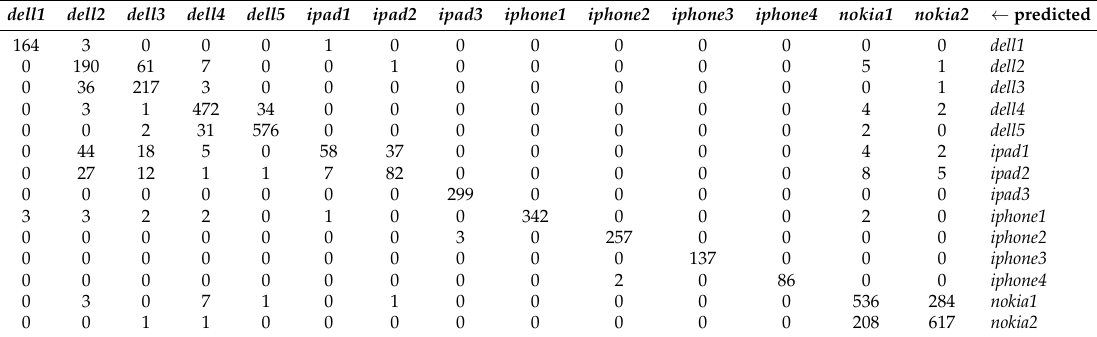
Table 10. k -NN performance for device